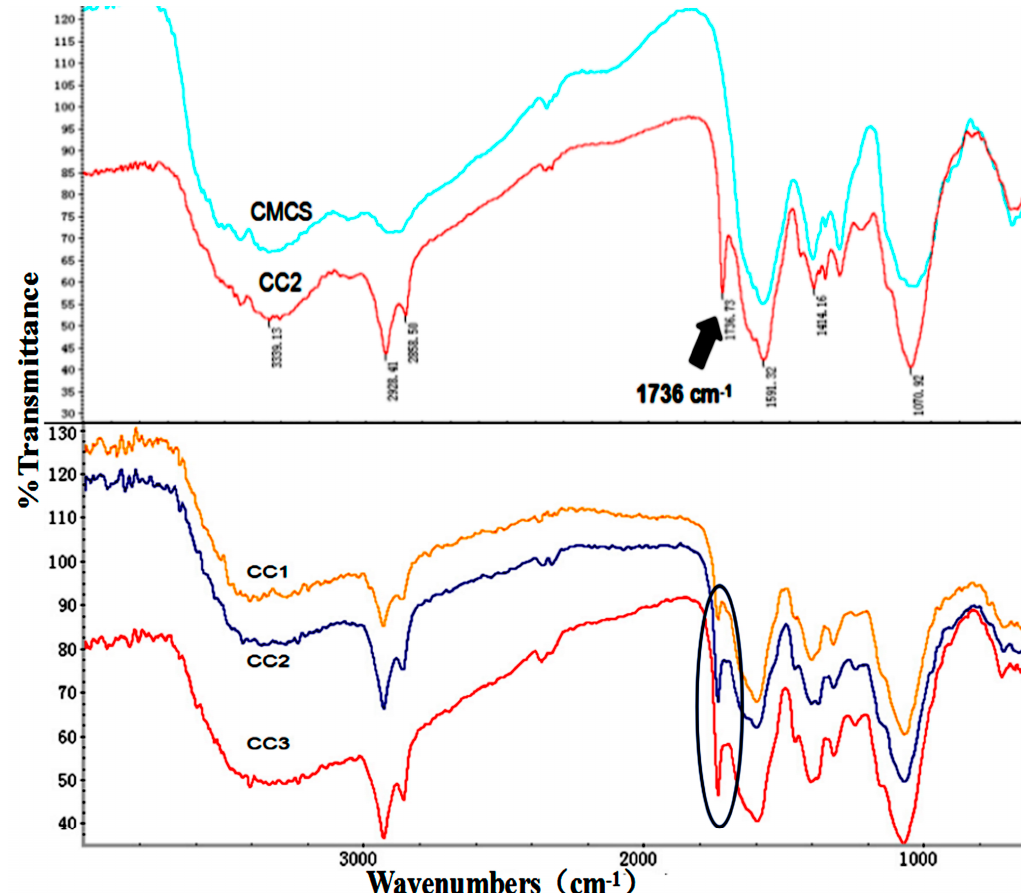
Figure 1. FTIR spectrum of carboxymethyl chitosan (CMCS) and CC1-3. CC: CLA - CMCS.